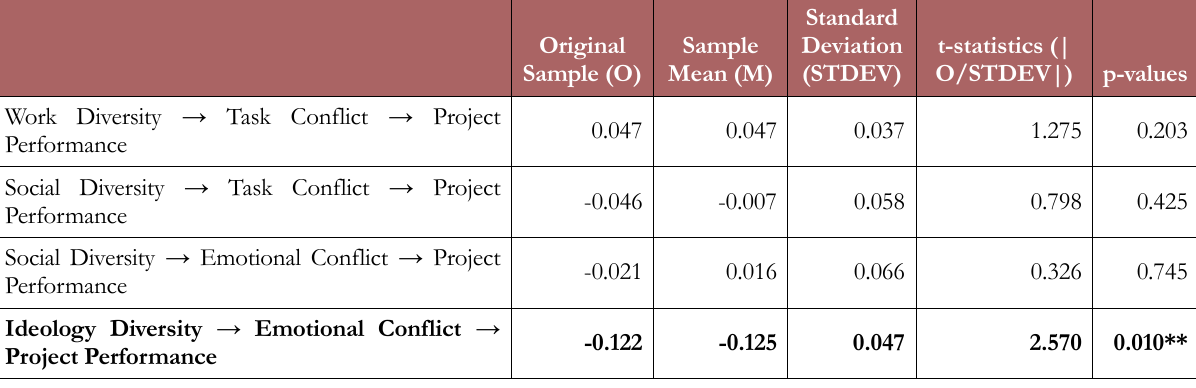
Table 12. Specific Indirect